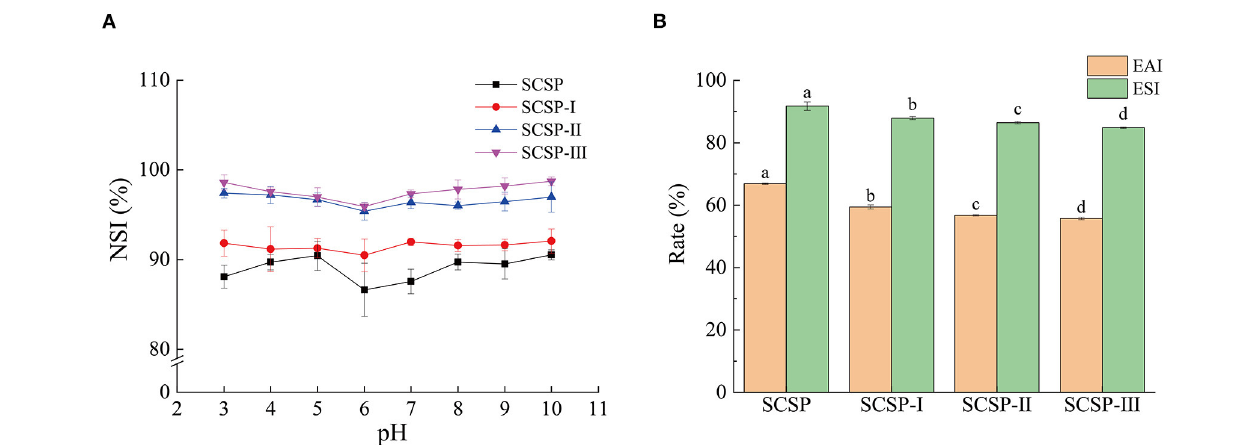
FIGURE 2 | Solubility (A) , emulsibility and emulsifying stability (B) of SCSPs. The 0.1 mg/mL and 50 mg/mL SCSPs were used in the tests of solubility and emulsibility, respectively. Different lowercase letters denote significant differences between SCSP, SCSP-I, SCSP-II, and SCSP-III groups ( P < 0.05). All experiments were repeated three times. Data are expressed as mean ± standard